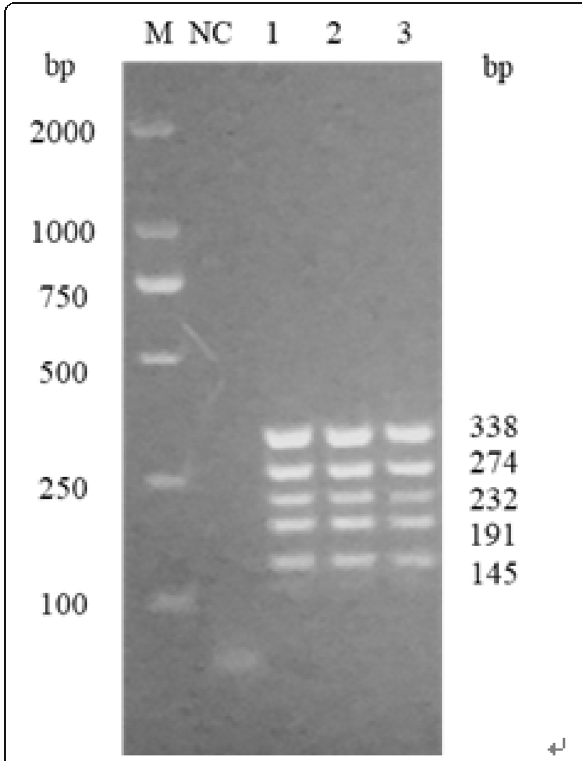
Fig. 2 The result of single tube multiplex PCR amplification of the PAH gene